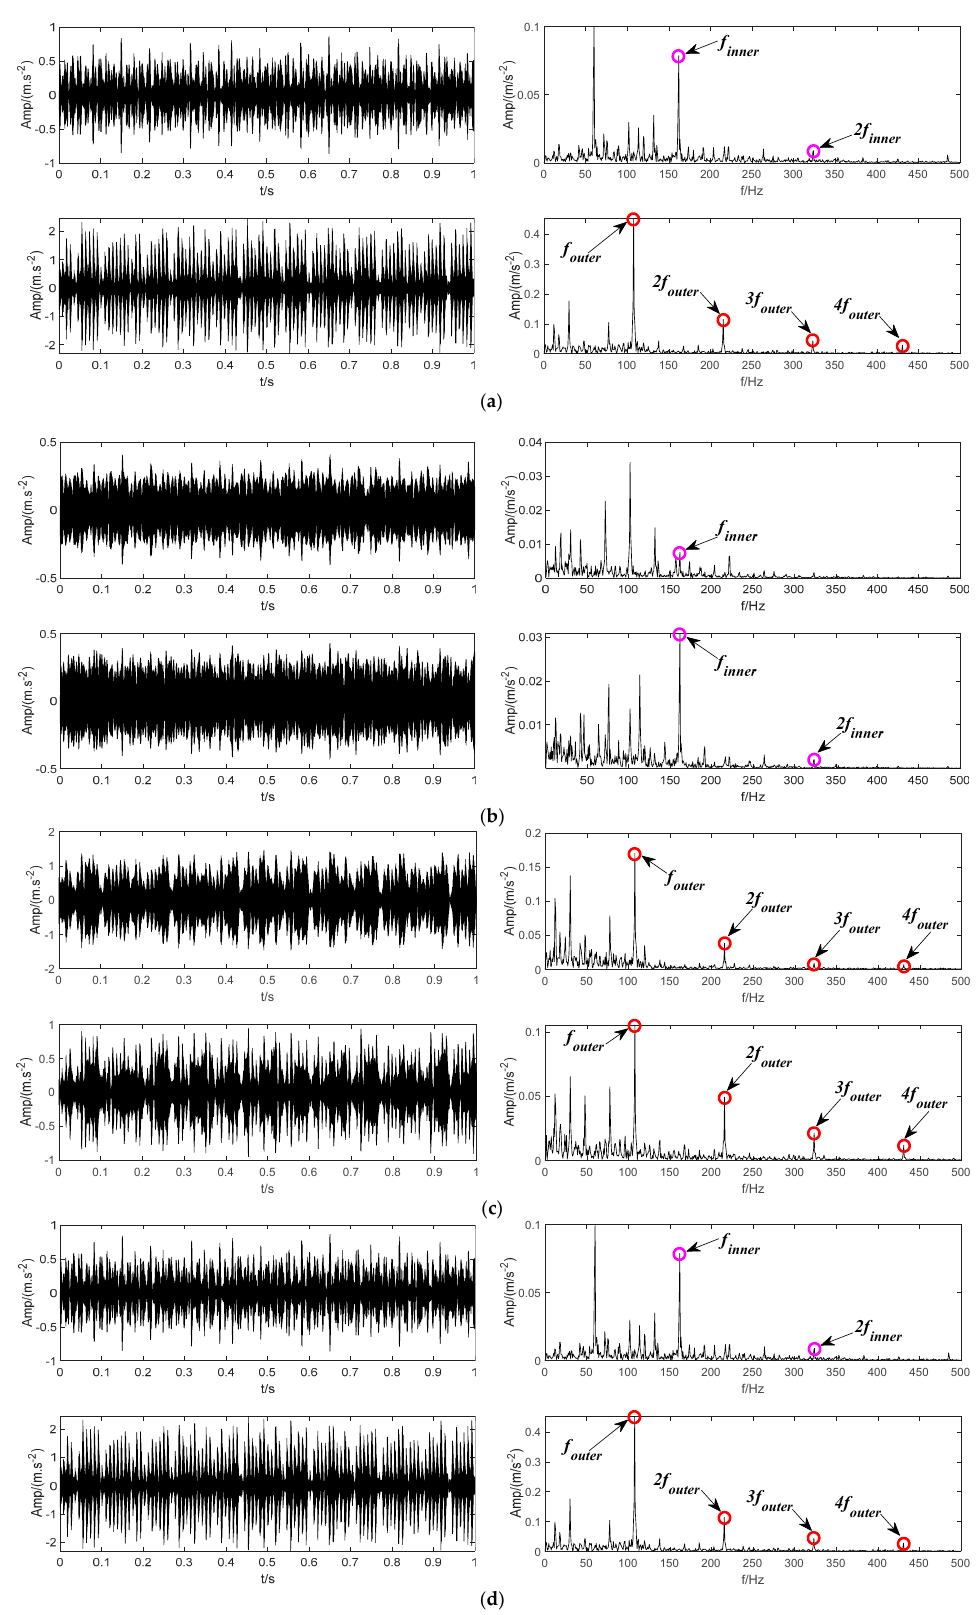
Figure 15. Original fault vibration signal: ( a ) Time-domain fault waveform. ( b ) Envelope spectrum.